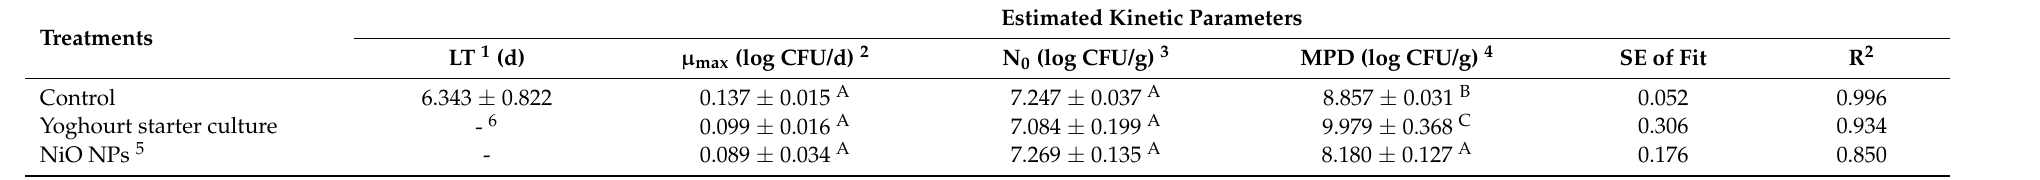
Table 1. Estimated growth parameters of Aerobic Plate Counts (APC) in Domiati cheeses using Baranyi model.